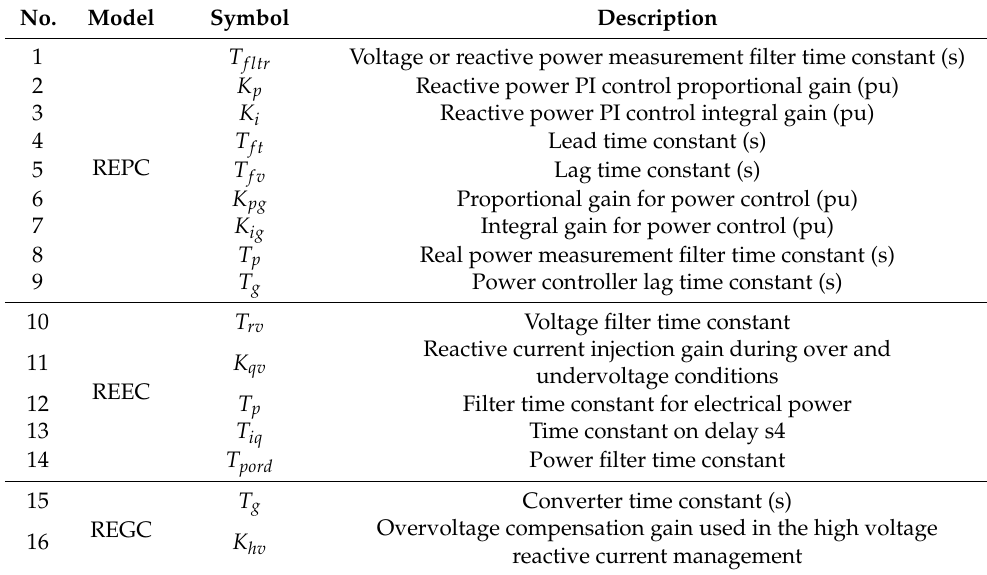
Table 5. The parameters for key parameter identification